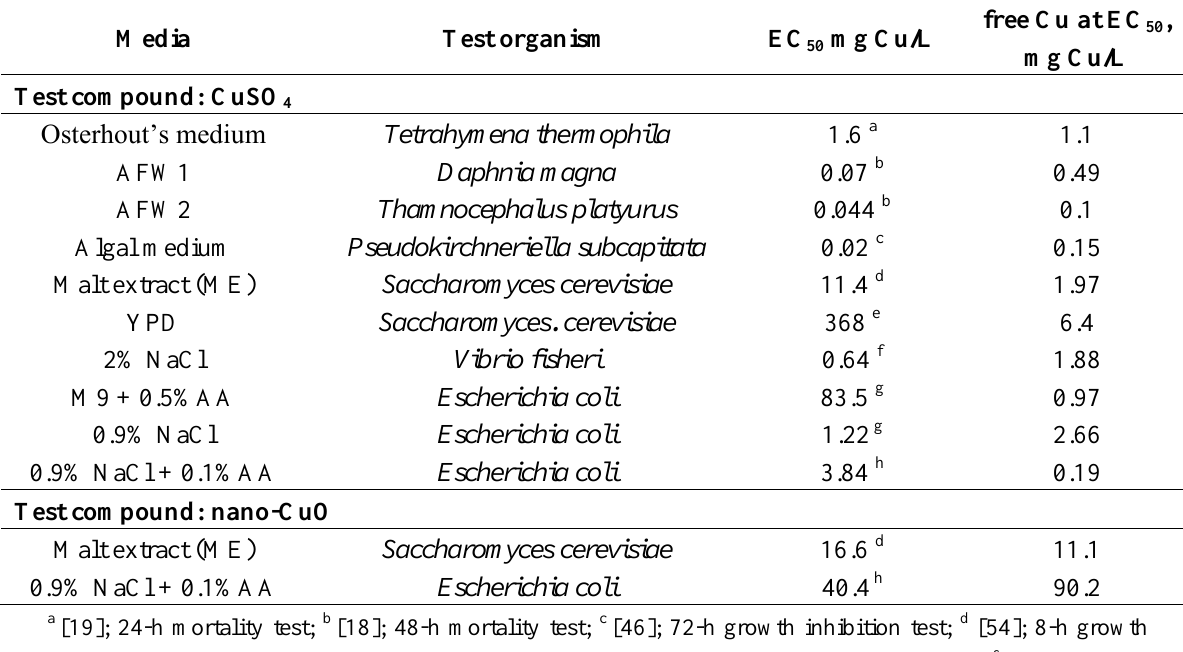
value) of CuSO and nano-CuO to different organisms in their 50 4 -s was calculated according to 50